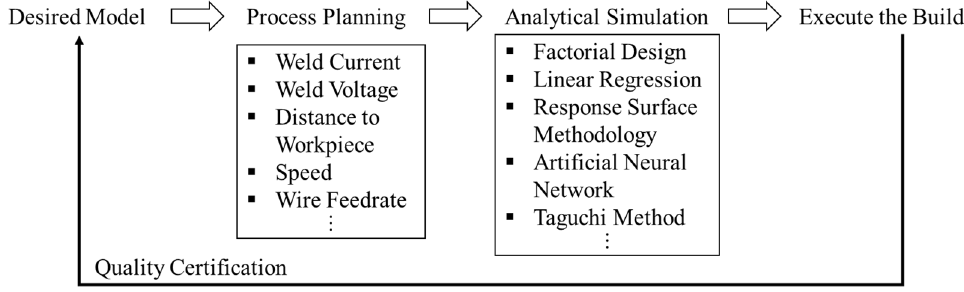
Figure 2. WAAM workflow and analytical approaches.